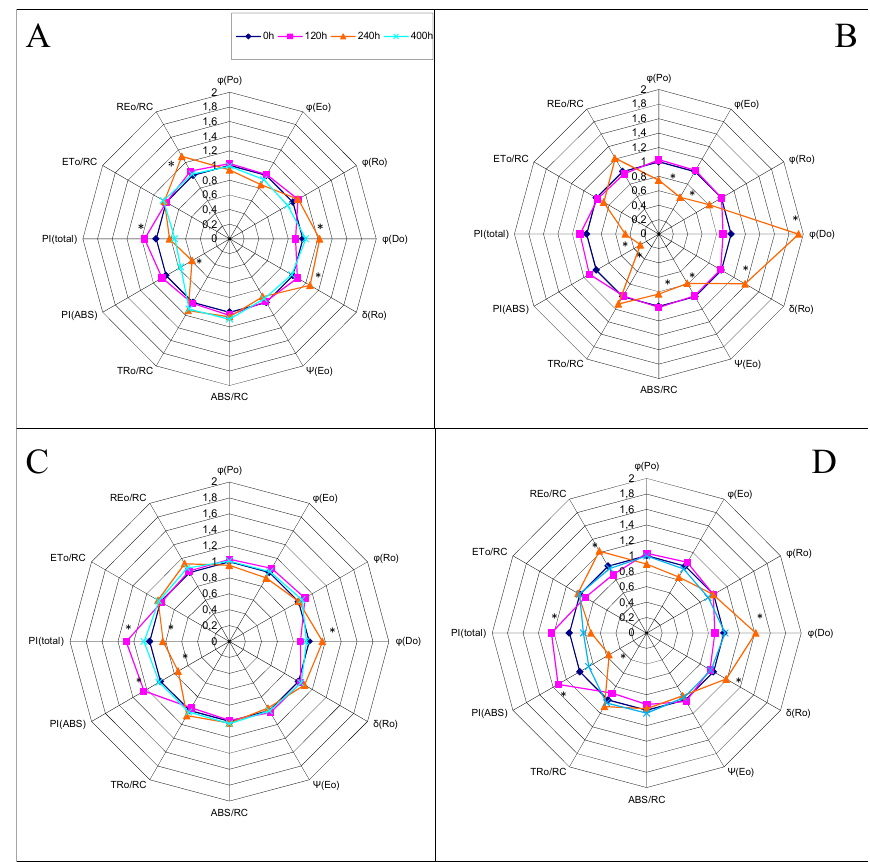
Figure 3. JIP-test parameters normalized to the values before stress application (0 h) as radar plots under different field water capacities of soil (50 and 30% FWC). ( A ) Roadrunner under 50% FWC, ( B ) Roadrunner under 30% FWC, ( C ) Nira under 50% FWC, ( D ) Nira under 30% FWC. Relative units. Means of one parameter marked by an asterisk differ significantly ( p < 0.05, n = 6).